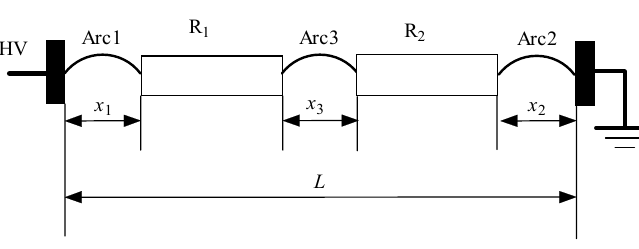
Figure 2. Model of the three